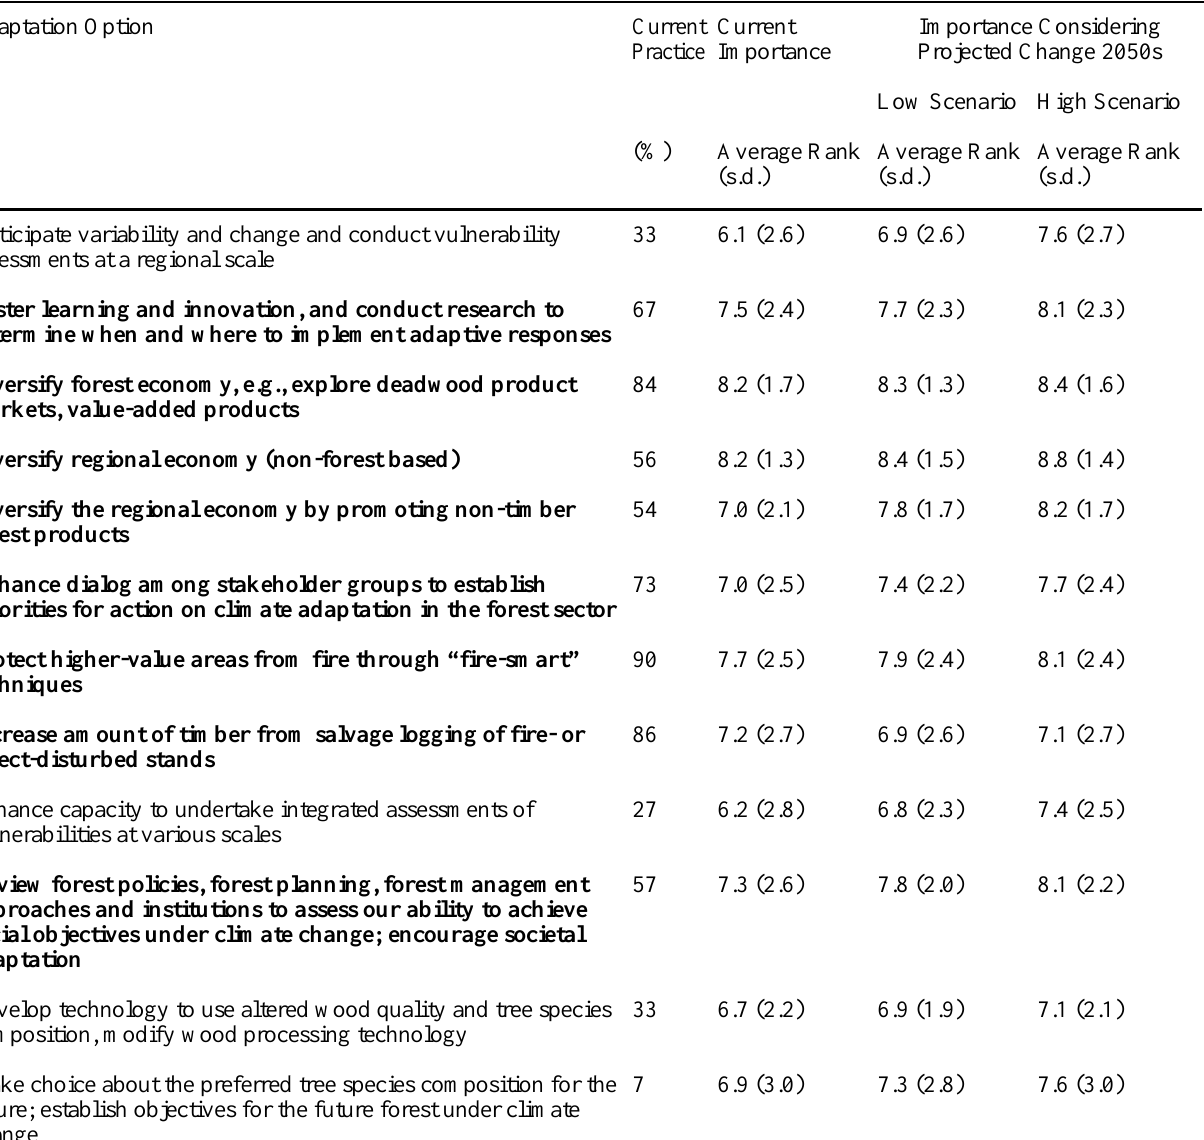
Table 9. Judgments of forest practitioners on the importance of adaptation options to maintain and enhance long-term multiple socioeconomic benefits to meet the needs of societies from forest ecosystems in the Champagne and Aishihik Traditional Territory for each of three scenarios: “current climate conditions,” “low scenario of future climate change by the 2050s,” and “high scenario of future climate change by the 2050s.” Scale of 1 to 10 (0 = no importance, 1 = low importance, 10 = high importance) or don’t know. Results shown are the average rank and standard deviation (s.d.) of participants who provided a ranking. The percentage of participants who agree or strongly agree with the statement “this management option is currently being practiced in the Yukon” is also provided. Adaptation options in bold are considered to be “no-regrets” (option is ranked 7 or higher across range of